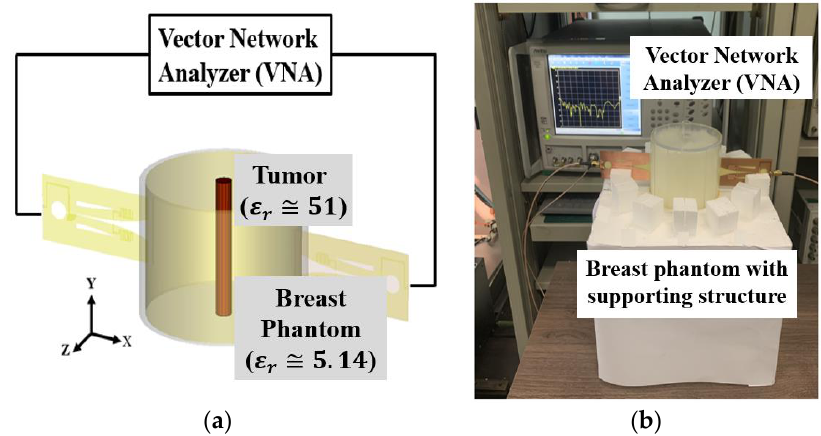
Figure 13. ( a ) Configuration of the backscattered signal measurement setup, and ( b ) picture of the experimental environment.